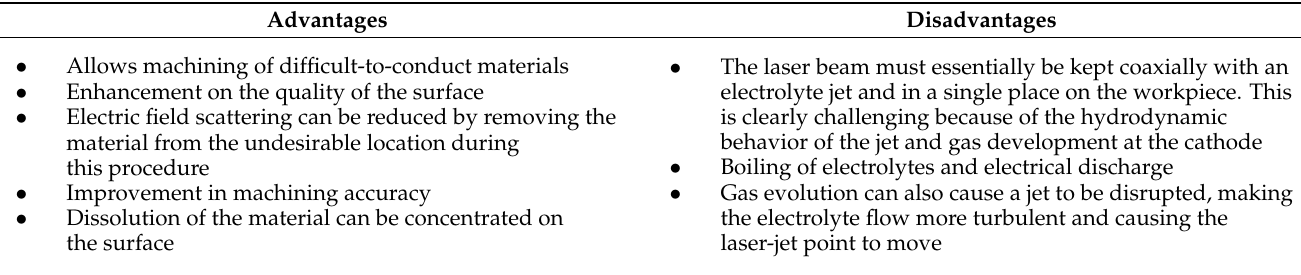
Table 23. Advantages and disadvantages of LA-JECM [292,293].